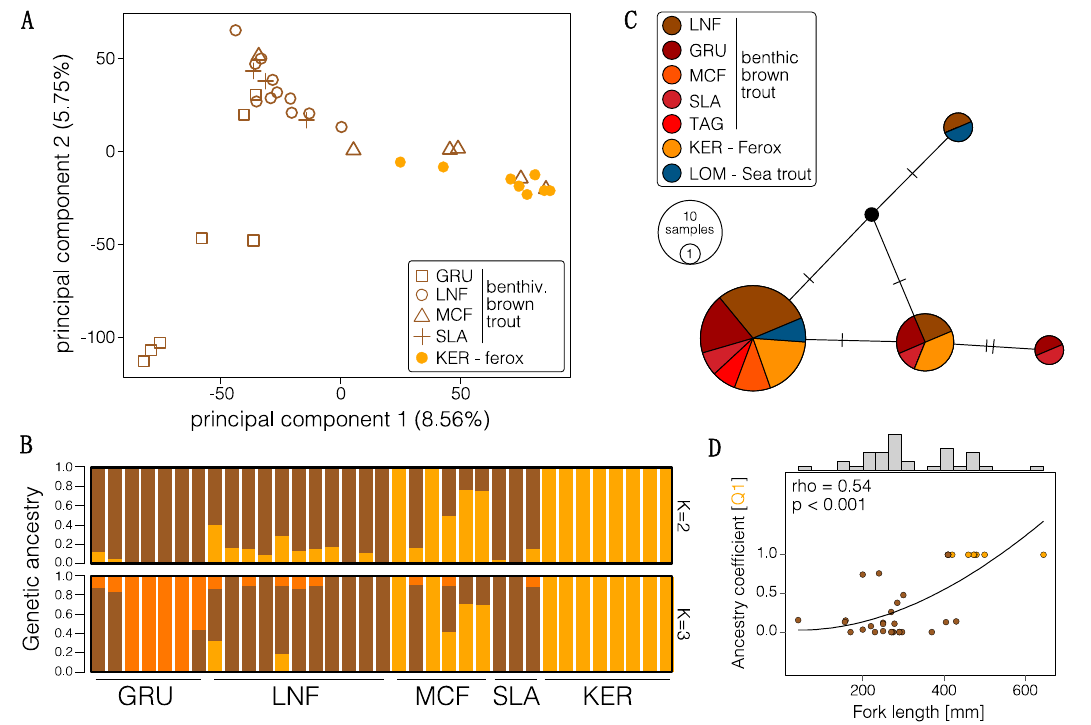
Figure 2. Population structure of brown trout. ( A ) Principal component plot showing the first and second axis of variation. ( B ) Proportion of genetic ancestry for two (K = 2) and three (K = 3) genetic clusters. Population codes are explained in Table 1. ( C ) A TCS-haplotype network based on the mitochondrial ND1 gene. ( D ) Correlation between genetic ancestry and fork length in brown trout from the Maree catchment. The grey area around the loess-smoothed line shows the standard error. Ferox trout (orange) had an average fork length of 483 ± 72 mm and benthivorous brown trout (brown) had an average fork length of 267 ± 88 mm. Values for the analysis were not age-corrected, as information on the age of individuals was not available.